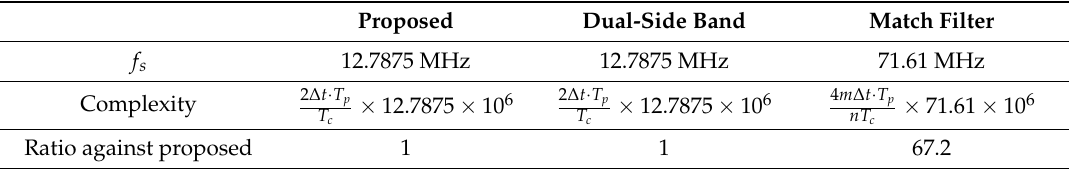
Table 2. Computational complexity.